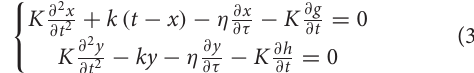
FIGURE 7 | The relationships between the adhesive and the projected length of the peel zone. The insert is the coefficient of determination R 2 when using a circle to fit the peel